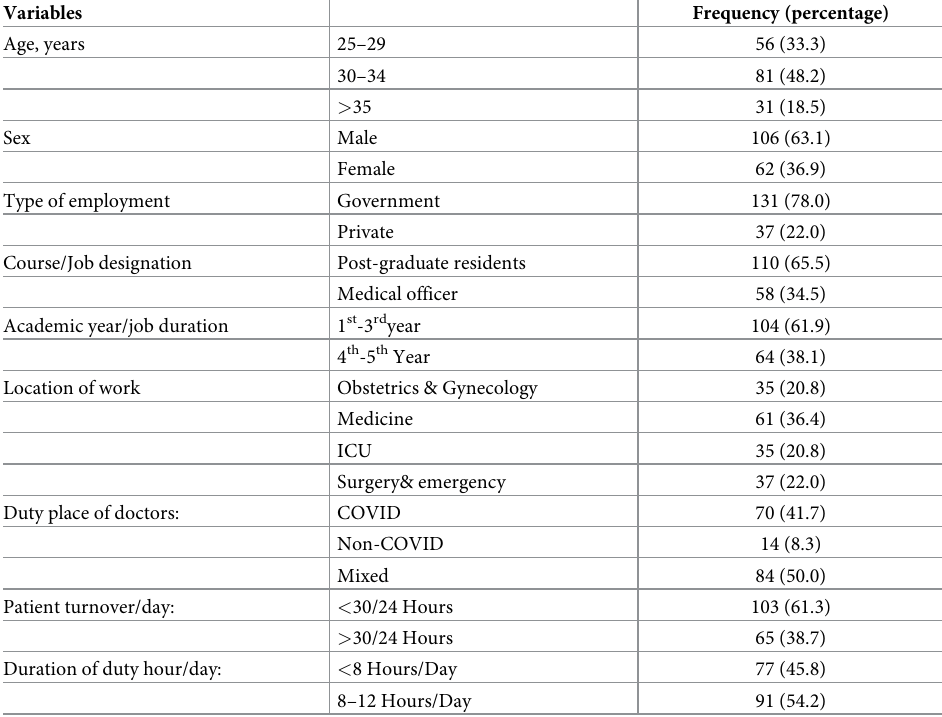
Table 1. Demographic and service-related characteristics of the participants (n =